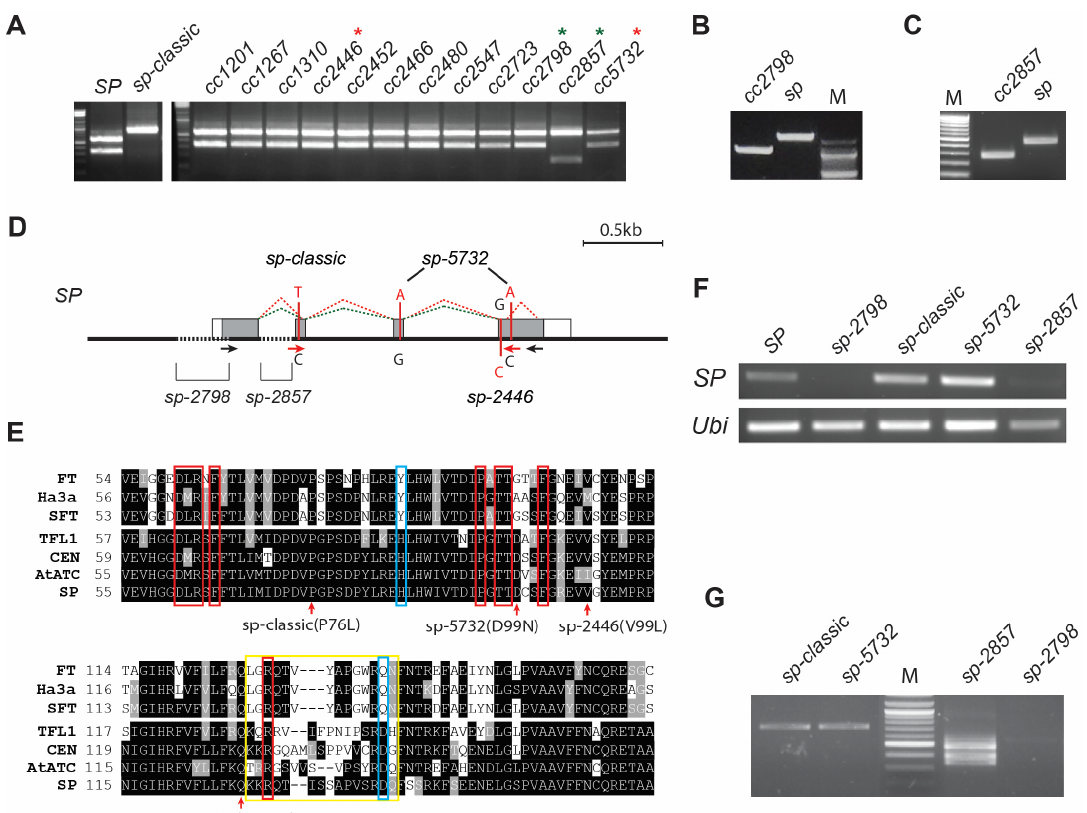
Figure 2. Identification of new sp alleles from core collections: ( A ) Genotyping by sp-classic CAPS marker. PCR products were digested by ScrFI cutting. SP and sp-classic are controls. Red asterisks, amino acid substitution sp mutants; green asterisks, new deletion sp mutant in SP locus. ( B , C ) Gel shift of PCR product amplifying 1kb SP promoter including the first exon ( B ) and amplifying the first exon and intron in SP locus ( C ). ( D ) Diagrams showing the SP gene structure and the locations of sp mutations. Dashed black lines indicate deletion regions of sp mutant. Dashed green and gray lines indicate mis-splicing of SP transcripts. red fonts, nucleotide substitution; white boxes, UTR; gray boxes, exon. ( E ) Partial alignment of SP homologs showing the external loop domain (yellow line box), residues binding to a 14-3-3 protein (red line boxes), and cue residues for florigen/antiflorigen function (blue line boxes). red arrows, sites of mutation substituted amino acid. ( F , G ) Semi-quantitative RT-PCR analysis of SP expression ( F ) and PCR amplification of full-length SP transcript including ORF ( G ) in sp mutant alleles and wild type ( SP ) at the shoot apex of SYM stage. Ubiquitin ( Ubi ) transcripts were used as PCR control. M, size marker.